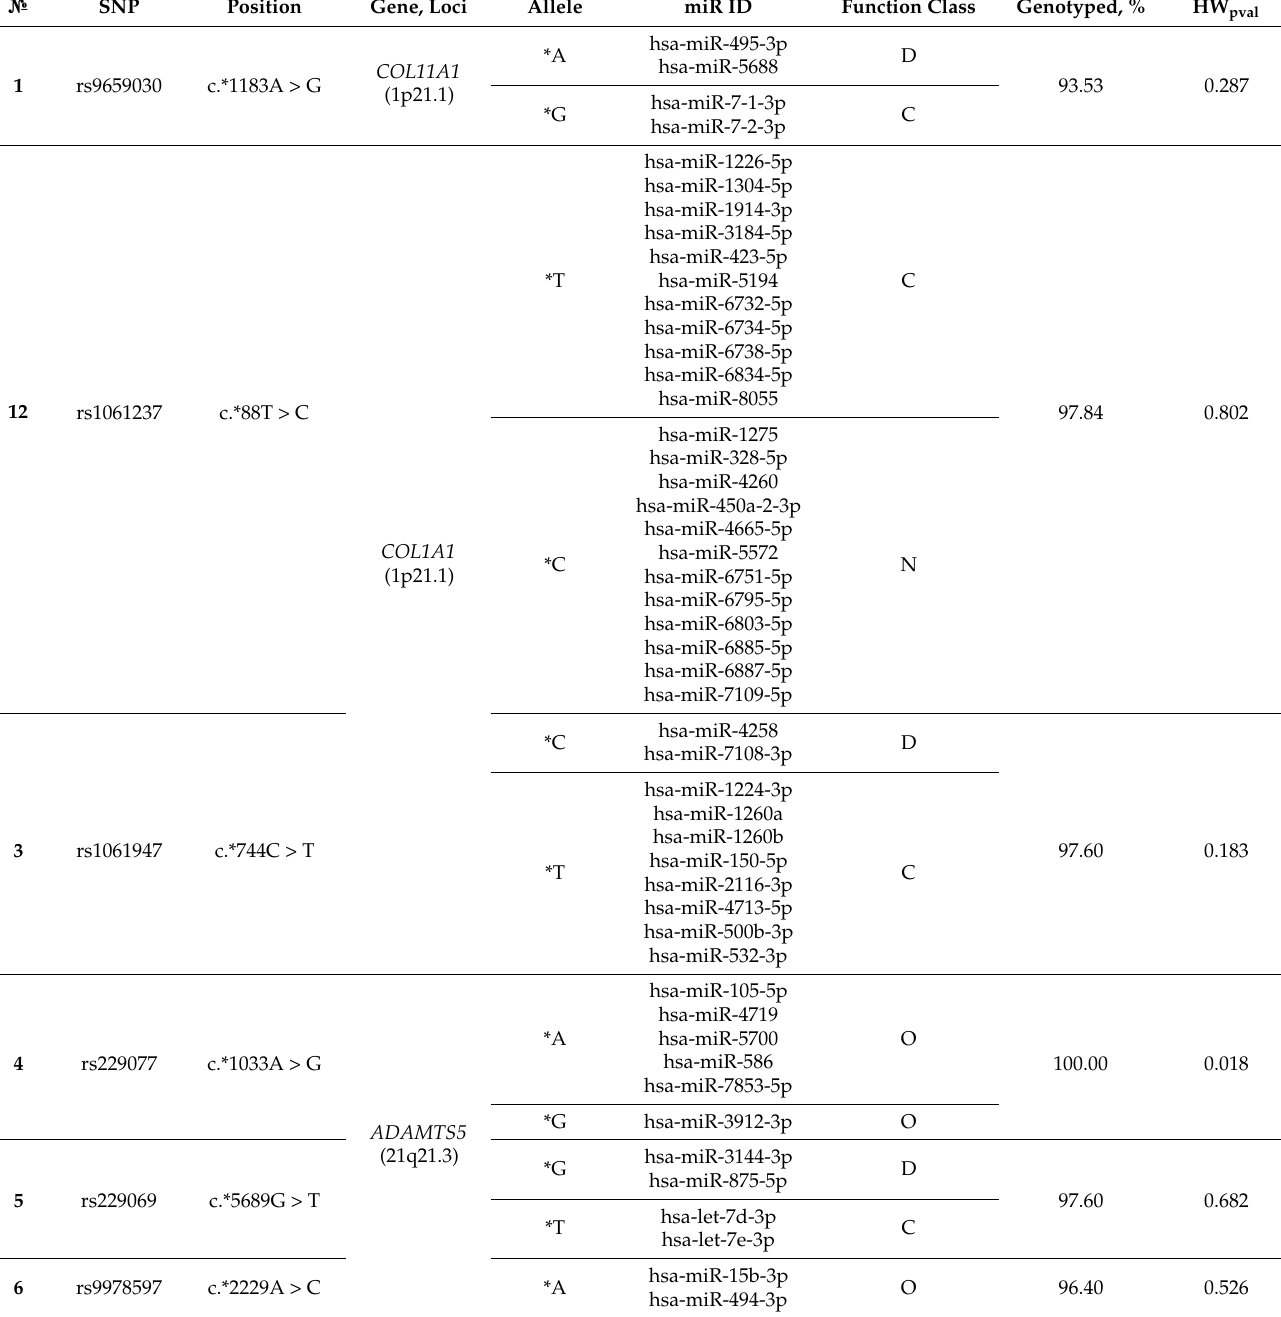
Table 2. Characterization of the studied loci in miRNA target